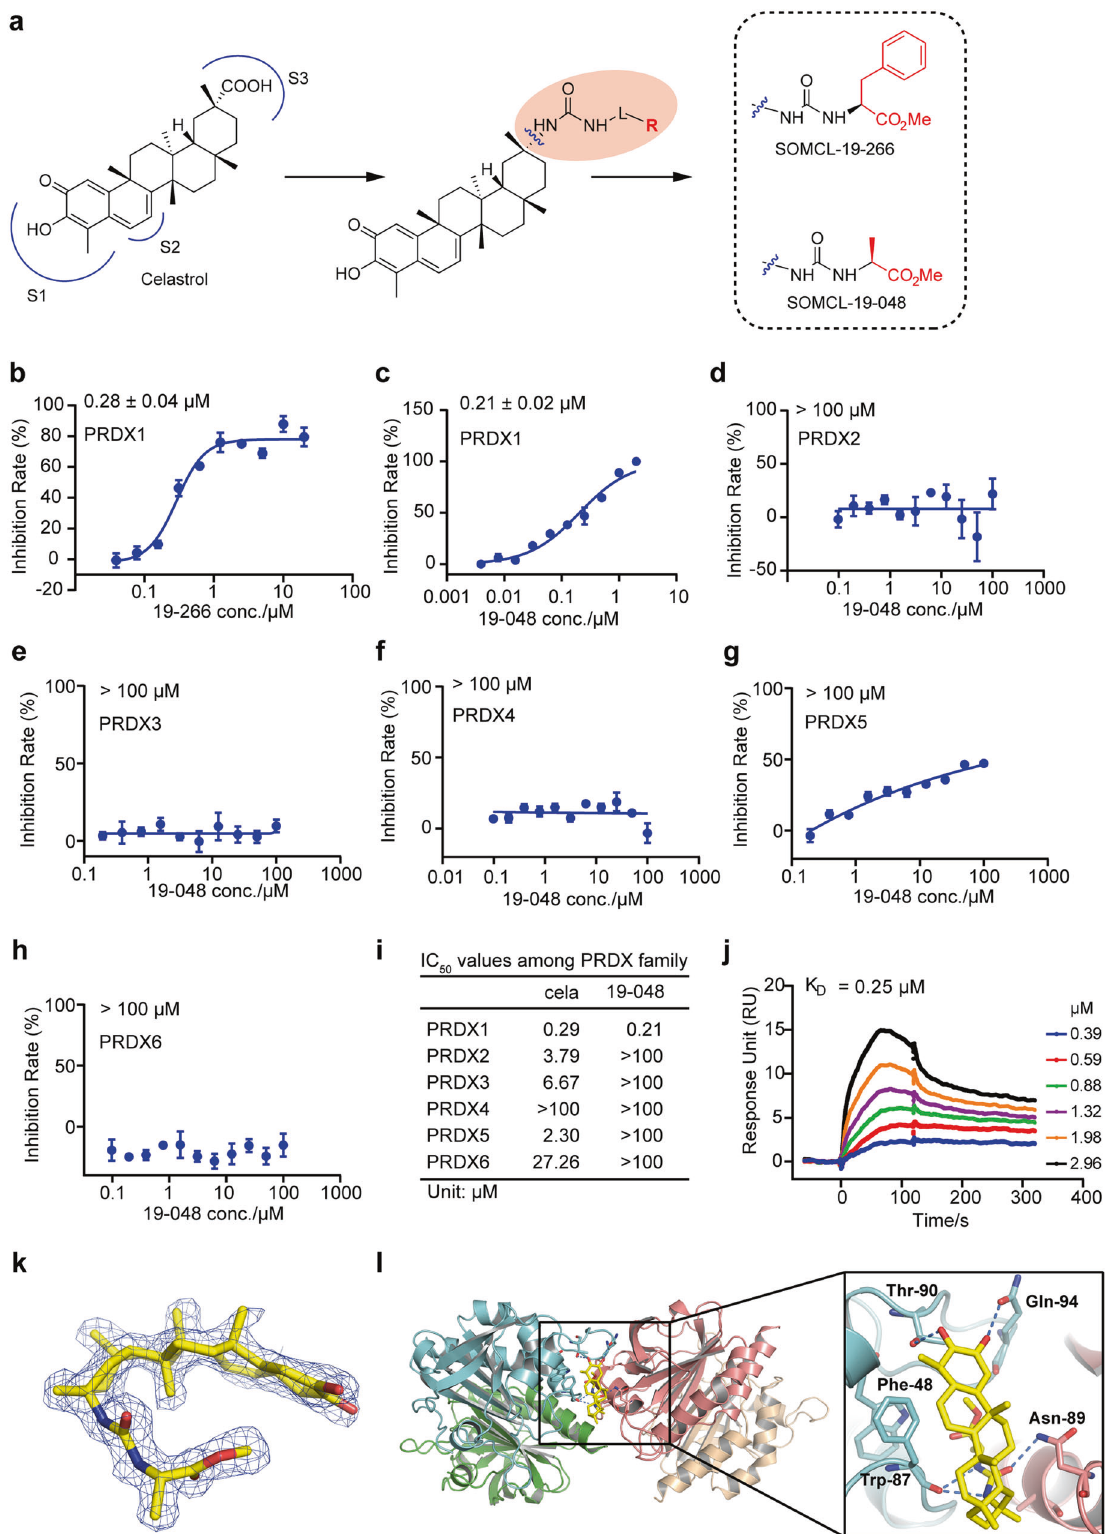
19-048 for 24 h, and the intracellular ROS positive rates were 26.5% and 29.13% at 2 μ M, respectively (Supplementary Fig. 6b), suggesting that Celastrol and compound 19-048 have less effect on the ROS induction in normal cells than in cancer